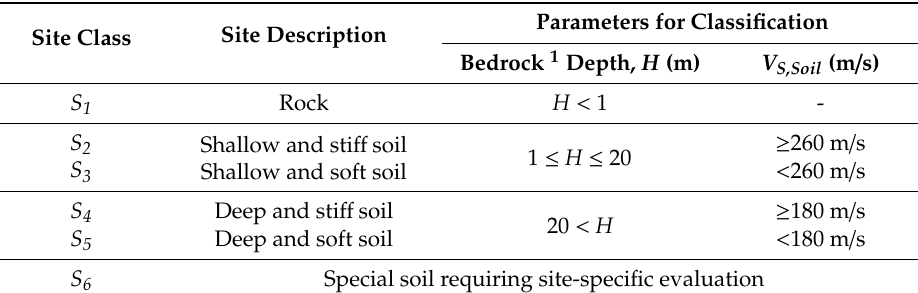
Table 2. Seismic site classification system of MPSS 2017